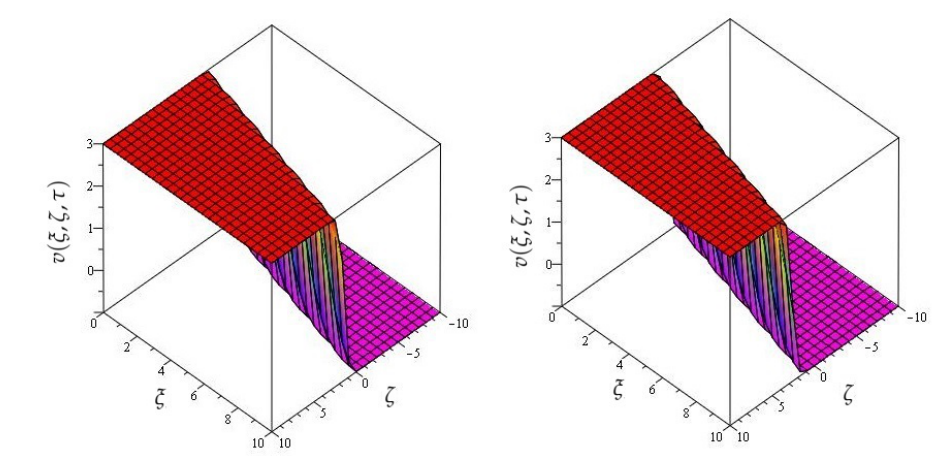
Figure 11. The numerical solution graph of v ( ξ , ζ , τ ) of Example 2 at β = 0.8 and